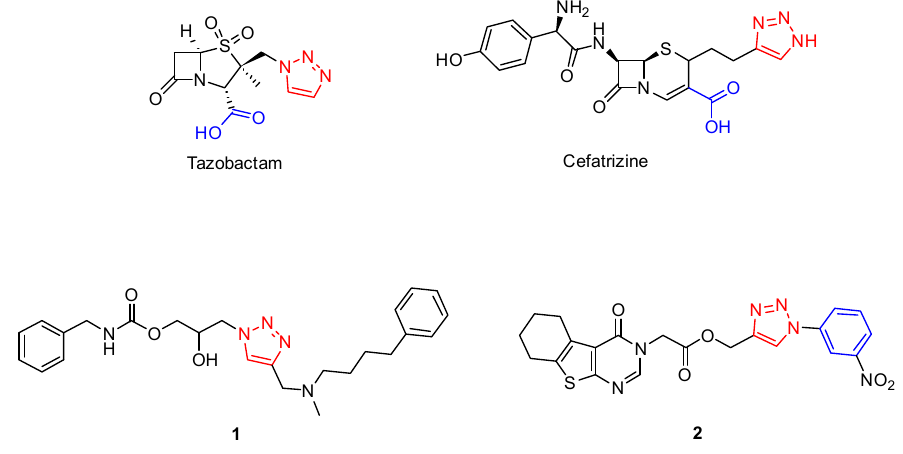
Figure 1. The structure of anti-bacterial agents containing the 1,2,3-triazole moiety based on FDA approved drugs and previous studies. approved drugs and previous